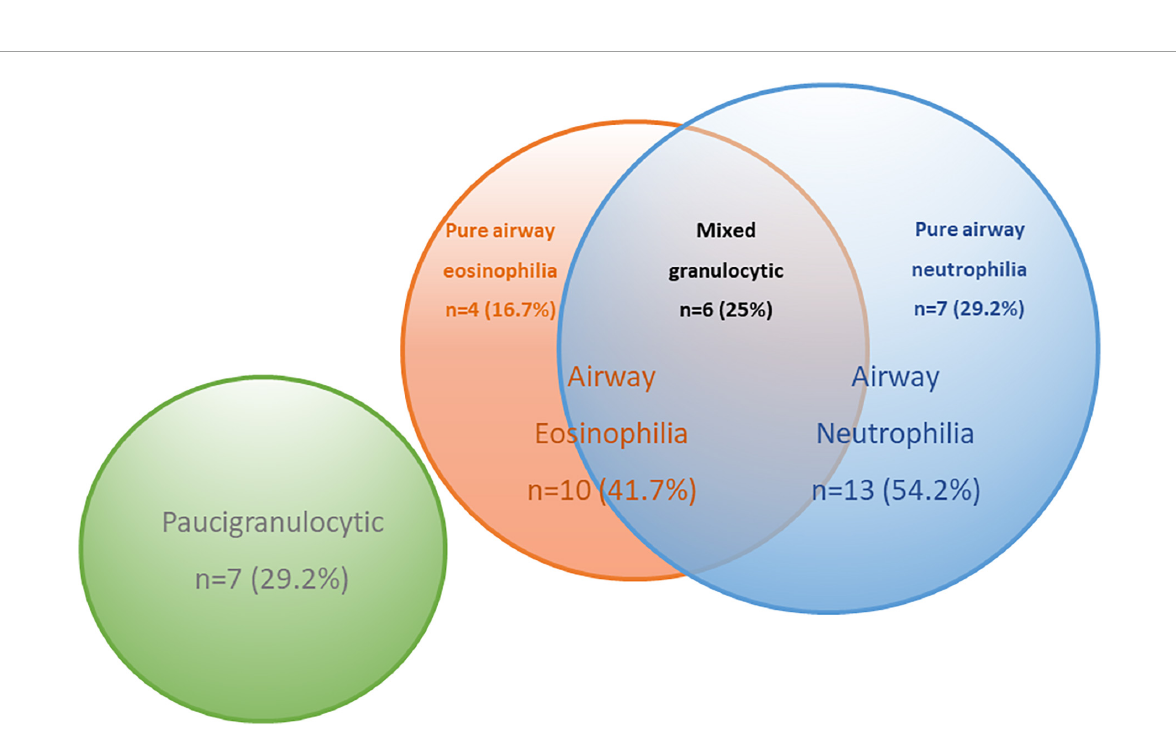
FIGURE4 Venn diagram to describe the inflammatory endotypes in the chronic obstructive pulmonary disease (COPD) subjects based on pre-defined